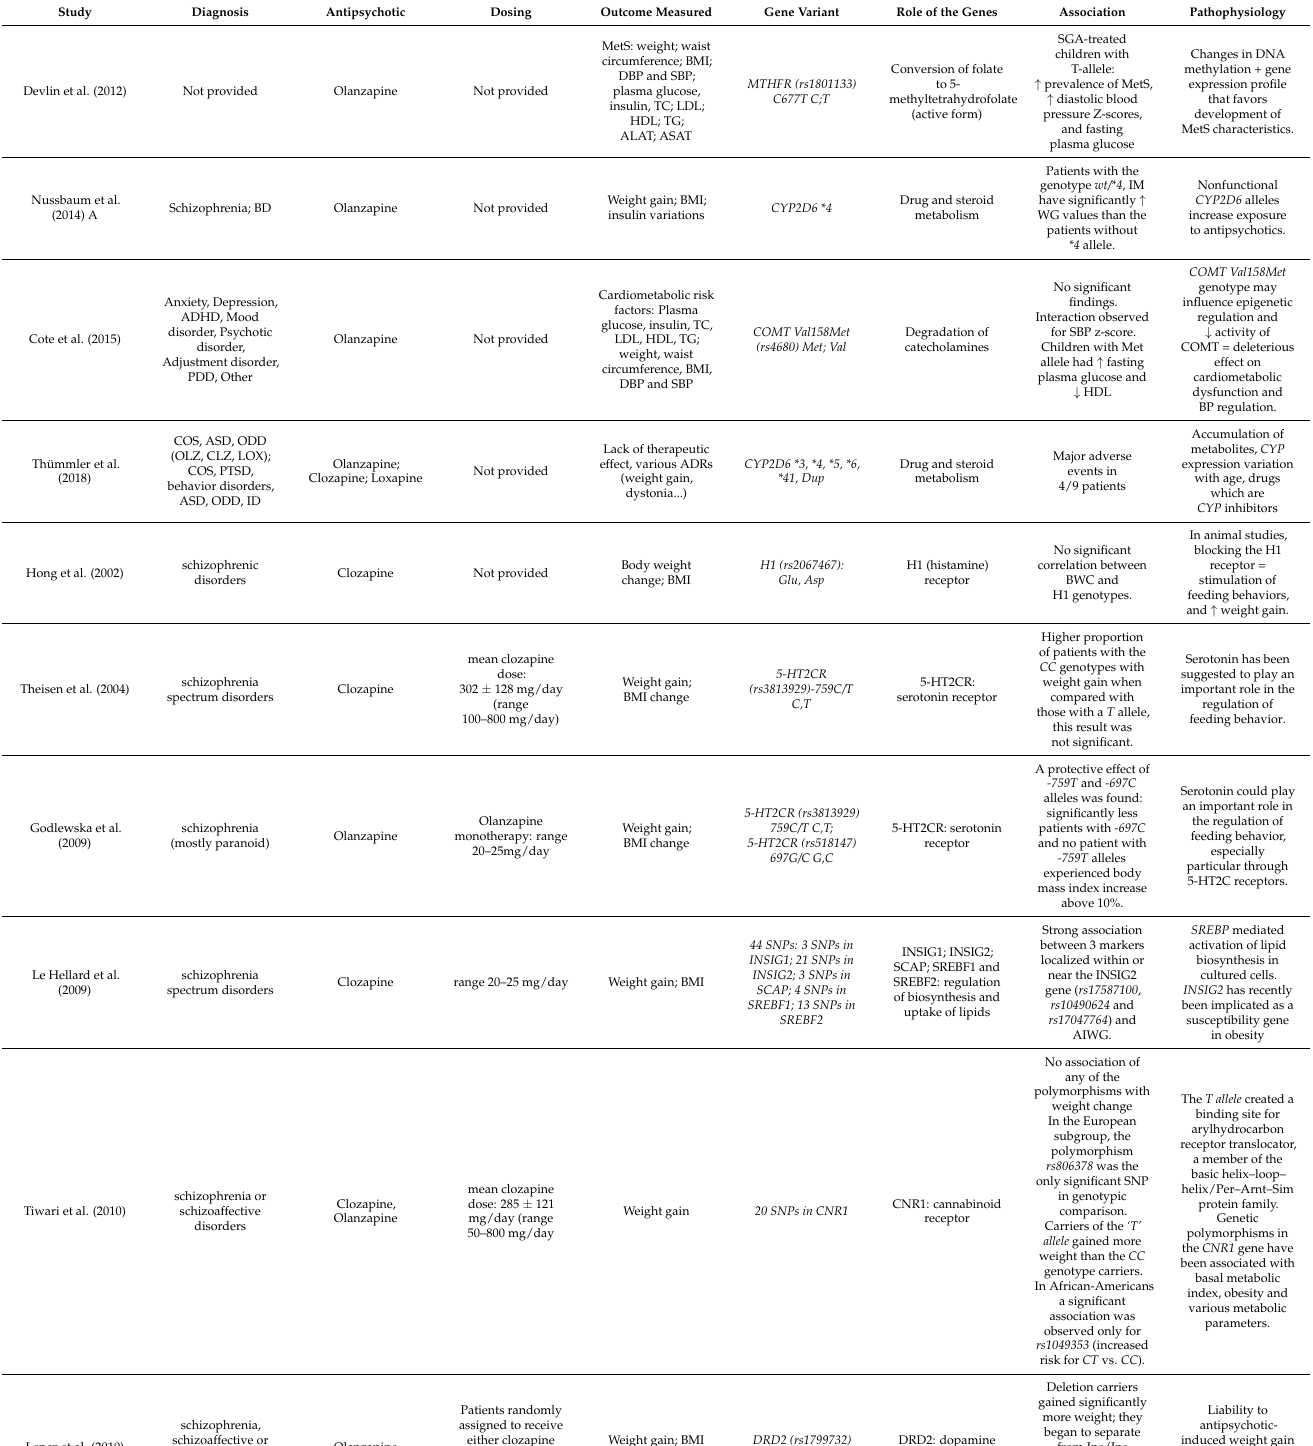
Table 3. Synthesis of studies investigating metabolic adverse drug